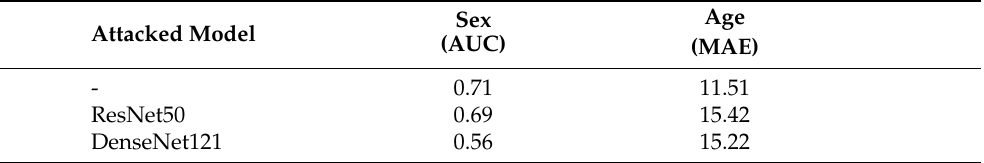
Table 6. Performance of the auxiliary models for predicting patient sex and age from X-ray images. We compare the classification/regression of original images, and images reconstructed from local ResNet50 and DenseNet121 models. All attacked clients provided 35 images in total. Metrics reported are AUC for sex prediction and the mean absolute error (MAE) in years for age